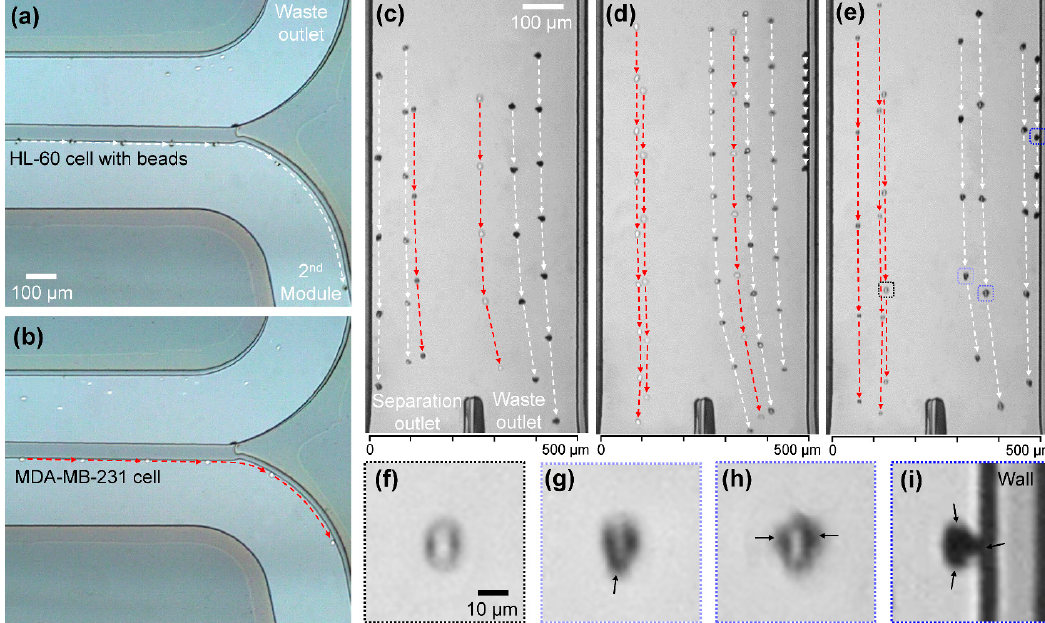
Figure 2. Demonstration of cell separation. ( a ) HL-60 cell and ( b ) MDA-MB-231 cell guided by the slanted weir in the physical separation module. HL-60 cells (white arrow) and MDA-MB-231 cells (red arrow) passing through the magnetophoretic separation module under various focusing buffer flow rates and magnetic field strength conditions of ( c ) 3 mL/h and 0 mT, ( d ) 3 mL/h and 20 mT, and ( e ) 5 mL/h and 20 mT. ( f – i ) Enlarged images of cells during separation from Figure 2e. ( f ) A separating MDA-MB-231 cell without a bead and separating HL-60 cells with ( g ) one bead (black arrow), ( h ) two beads, and ( i ) three beads.